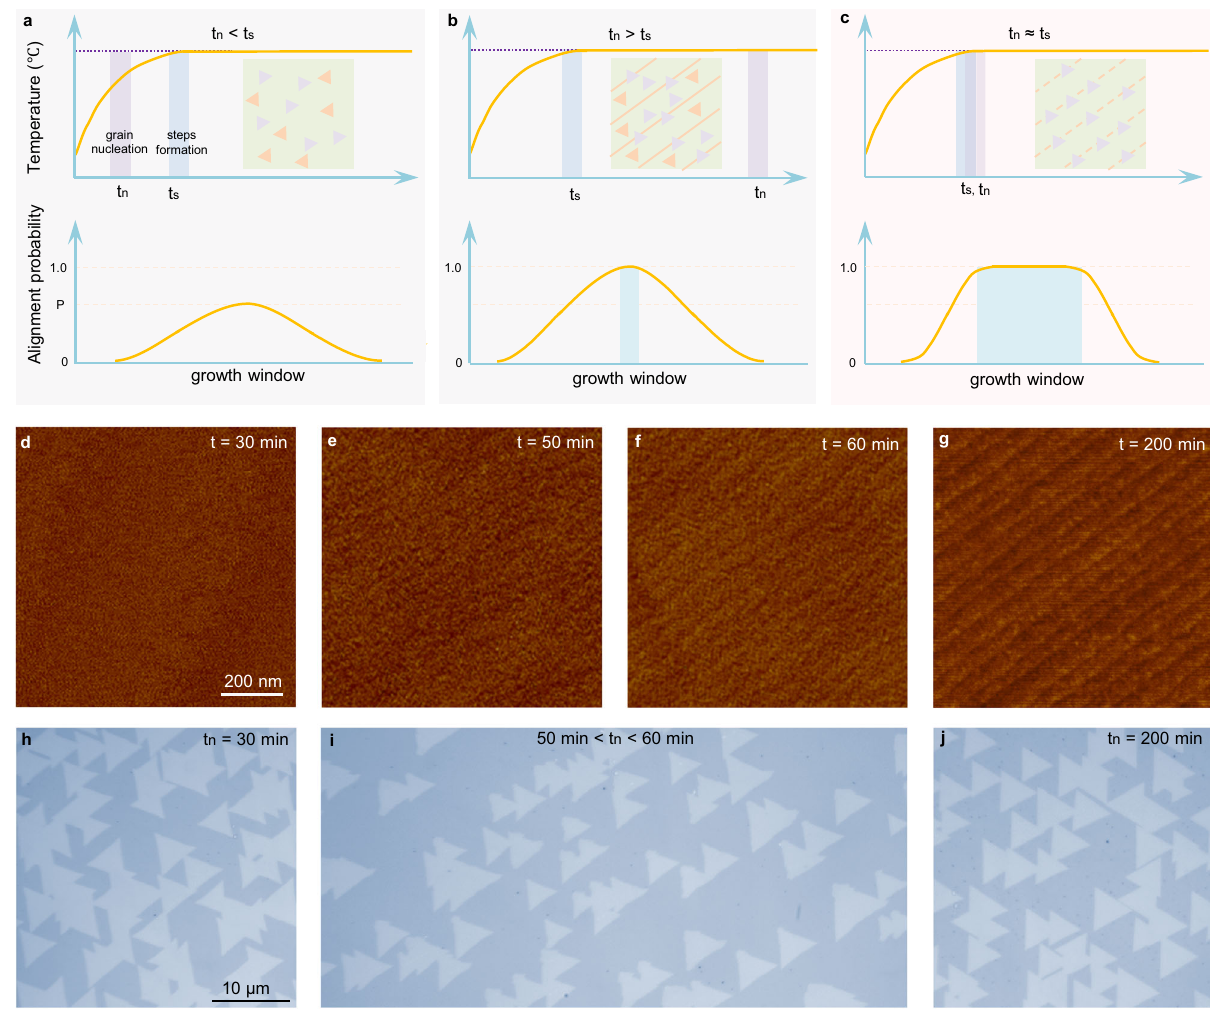
Fig. 1 | Growth of unidirectionally aligned MoS 2 grains by the simultaneous- formation-guided mechanism. a – c Schematic diagrams of the growth behaviour ofnon-centrosymmetric2Dgrainswhent n <t s ( a ),t n >t s ( b )andt n ≈ t s ( c ).T n andt s are the 2D grains nucleation and atomic steps formation time, respectively. The shadedcolouredareasrepresentthetimewindowoft n andt s .Theviolethorizontal dashedlinesrepresentthegrowthtemperature.Theyellowhorizontaldashedlines correspond to the alignment probability of 1.0 and a certain value P. The growth window of 2D single crystals is greatly broadened when t n ≈ t s . d – g Atomic force